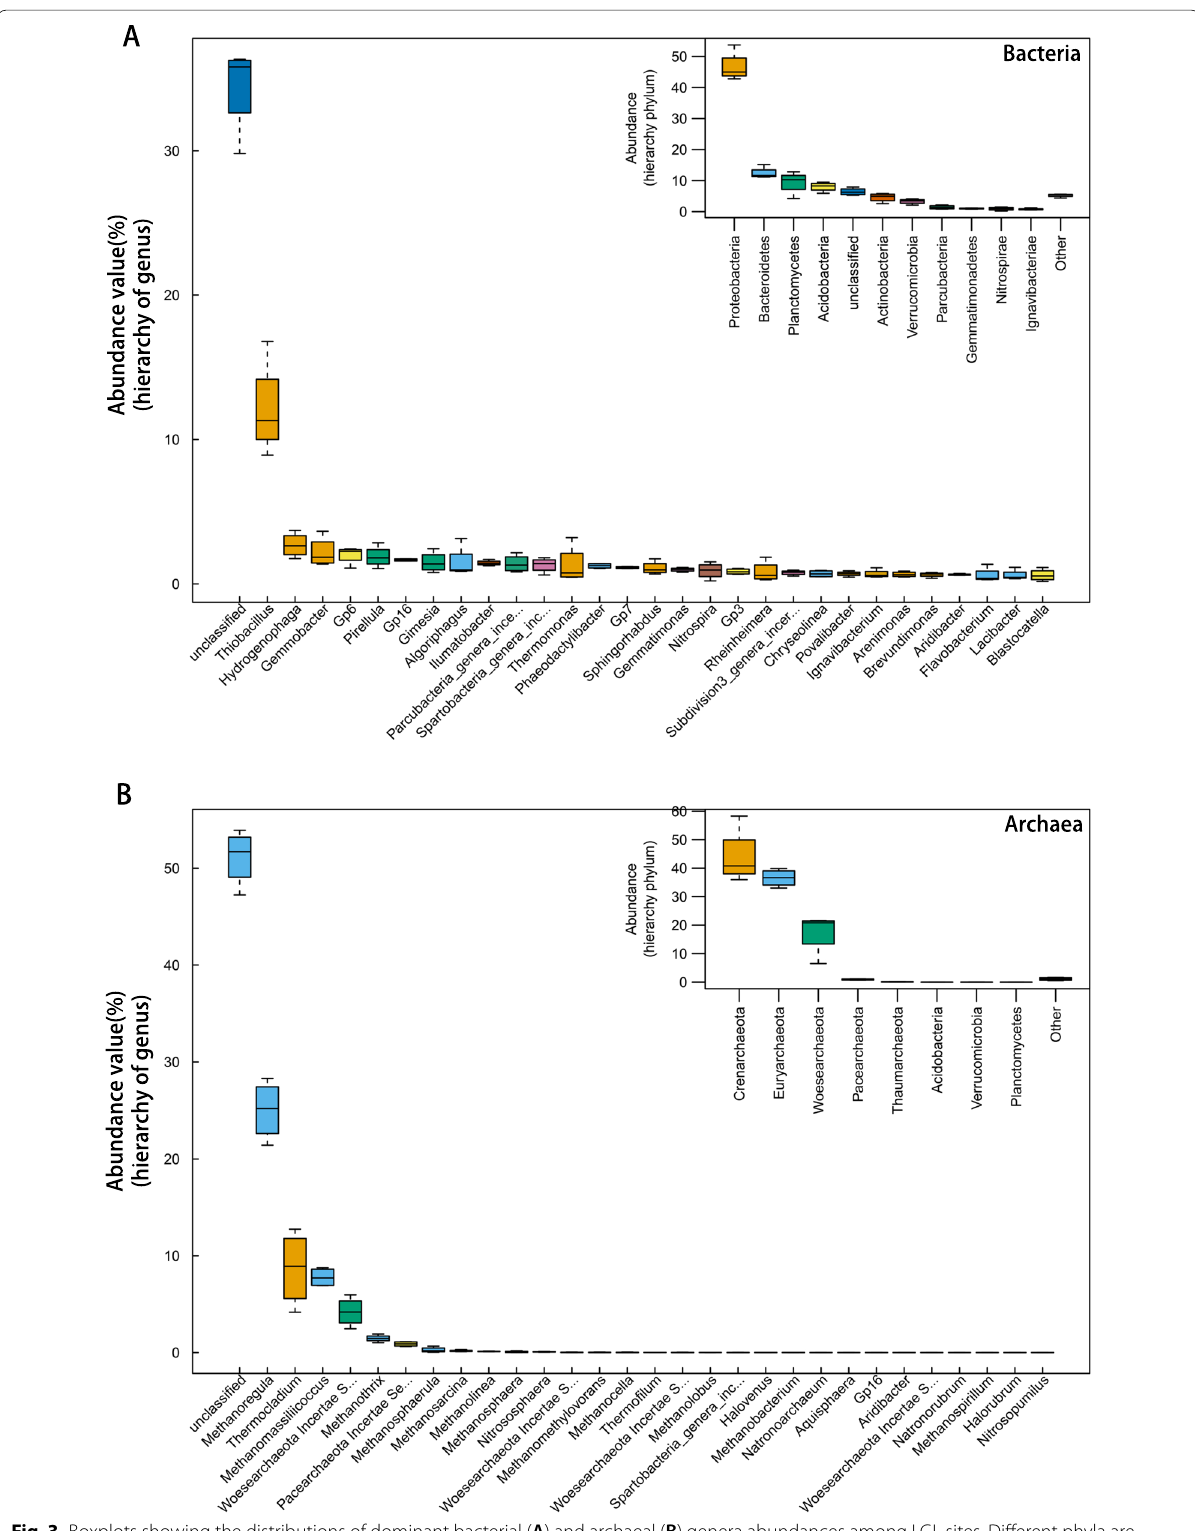
Fig. 3 Boxplots showing the distributions of dominant bacterial ( A ) and archaeal ( B ) genera abundances among LGL sites. Different phyla are indicated by different colors (as indicated in the top right corner), while genera within the same phylum are indicated with the same colors. Dominant taxa are indicated in red